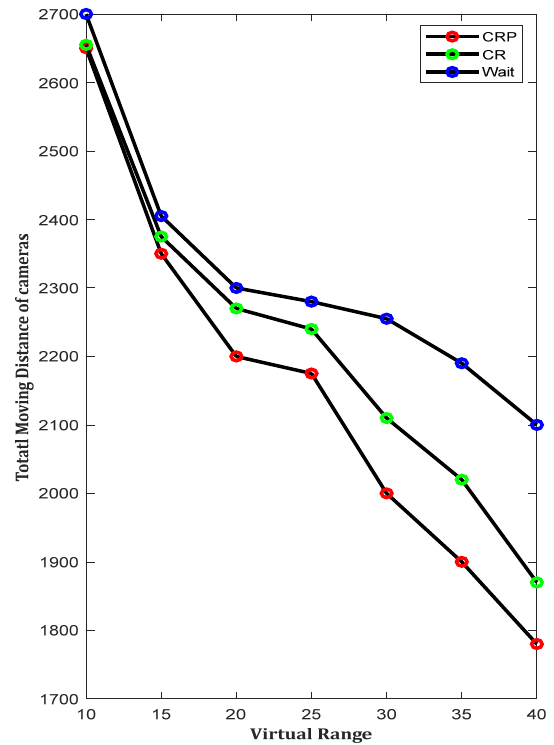
Figure 6. Total moving distance of cameras vs. virtual range.